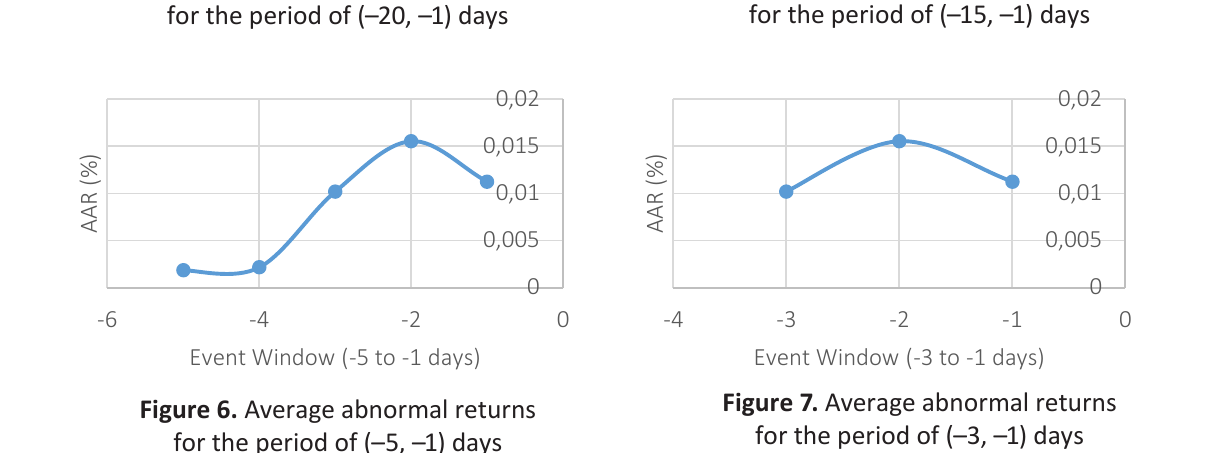
Figure 7. Average abnormal returns for the period of (–3, –1) days